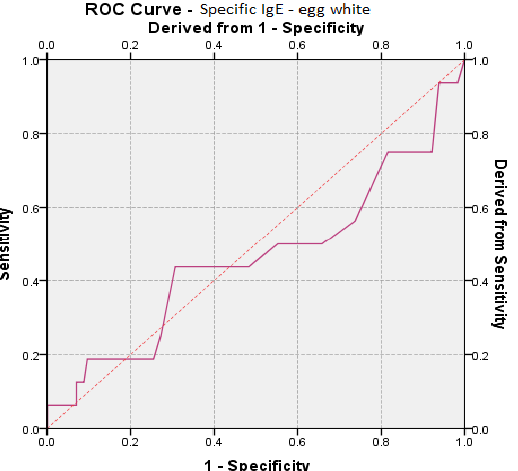
Figure 4. ROC (receiver operating characteristic) curve for egg white specific IgE prediction vs. re- mission of the disease.